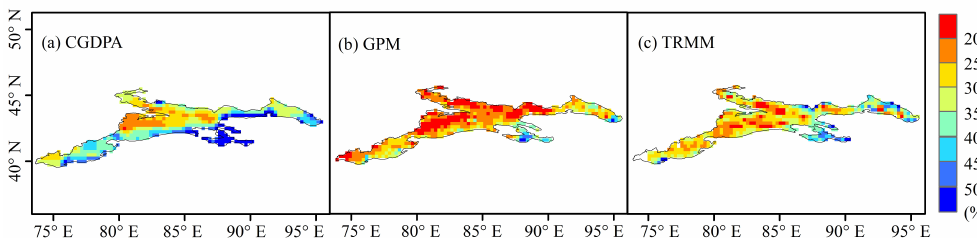
Figure 3. Spatial distribution of CV values (%) of daily precipitation in Tianshan from 1 April 2014 to 31 March 2015.